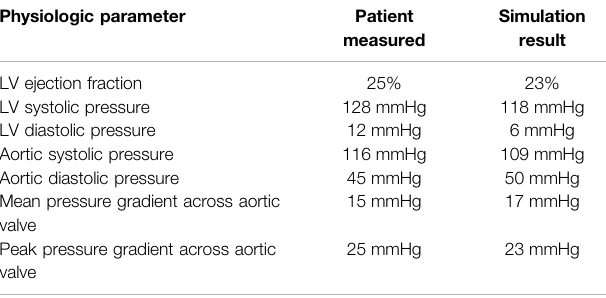
TABLE 1 | Comparison of patient clinical parameters compared to simulation results. Physiologic parameter Patient